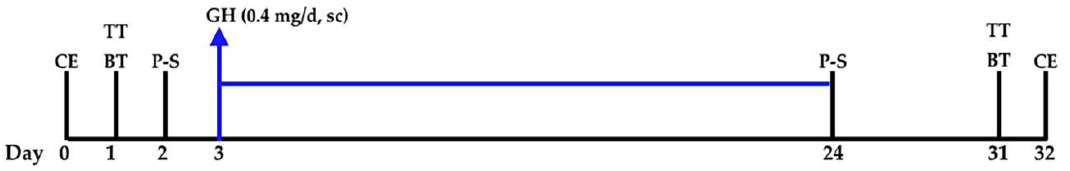
Figure 4. After the clinical examination (CE, day 0), a blood test (BT: hematimetry, biochemistry, hormones, and plasma tumoral markers) was performed; day 1. In the same day, a Tavec test (TT) was carried out. One day later, a FDG-PET-SCAN (P-S) was carried out; day 2. The next day (day 3), the patient began to be treated with GH for 21 days (0.4 mg/day, subcutaneously (sc), blue arrow and blue line). Twenty-one days later, a new FDG-PET-SCAN was performed just 1 h after the last administration of GH (day 24). Seven days later, a new BT and a TT were performed (day 31), and one day after this, a new clinical examination was performed.